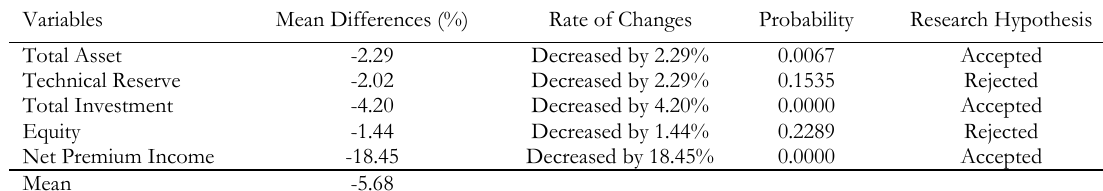
Table 3. Results of the Dependent t-test for the Differences in the Growth (y-o-y)